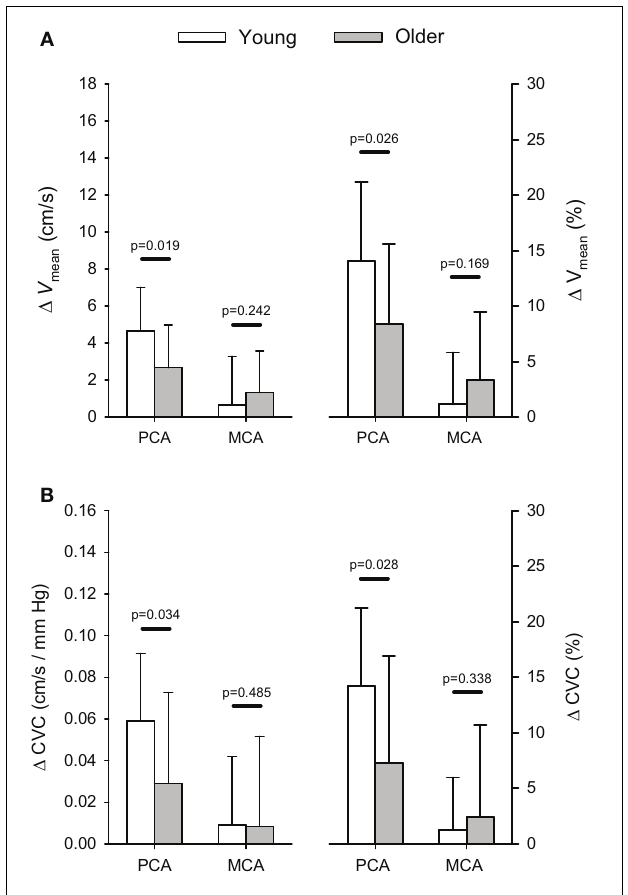
FIGURE 3 | Absolute (cm/s) and relative (%) changes ( (cid:2) ) in posterior (PCA) and middle cerebral artery (MCA) blood velocity (A) and cerebrovascular conductance (B) in response to euoxic hypercapnic test. P -values provided for comparison between young and older